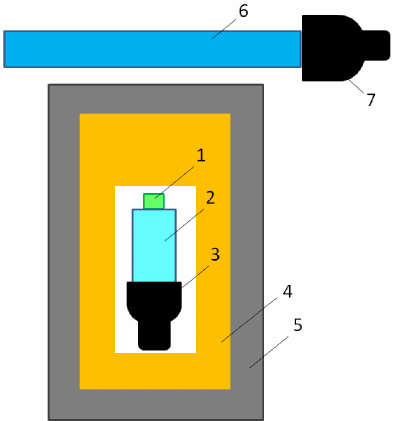
Figure 9. Schematic view of the experimental set-up with the SrI 2 (Eu) scintillation detector. The SrI 2 (Eu) crystal scintillator (1) is viewed through a polystyrene light-guide (2) by a photo-multiplier tube (3). The detector is surrounded by copper (4) and lead (5). The polystyrene based plastic scintillator of the anti-muon veto counter (6) is viewed by a photo-multiplier tube (7).